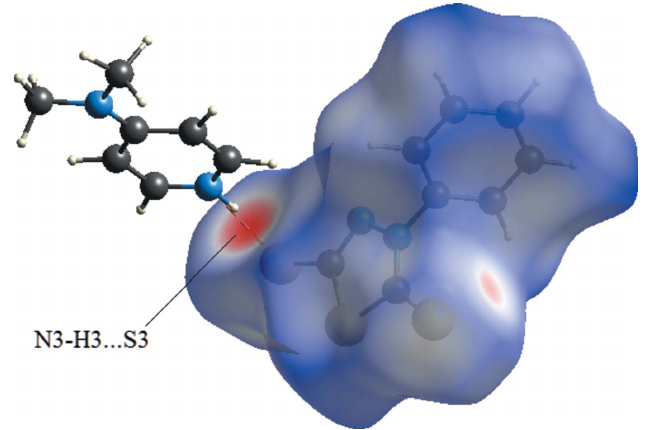
Figure 7 The Hirshfeld surface mapped over d norm for compound (II) indicates that the most important contributions to the crystal packing are from S (cid:2)(cid:2)(cid:2) H/H (cid:2)(cid:2)(cid:2) S (35.3%), H (cid:2)(cid:2)(cid:2) H (31.5%) and C (cid:2)(cid:2)(cid:2) H/H (cid:2)(cid:2)(cid:2) C (20.3%) inter-